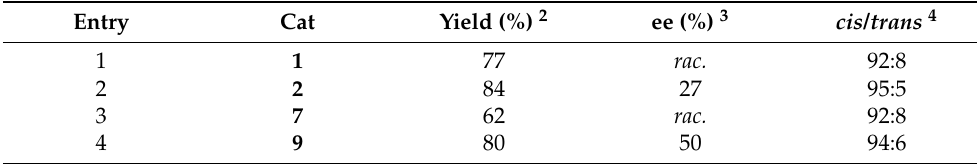
Table 1. Preliminary screening for the model reaction 1